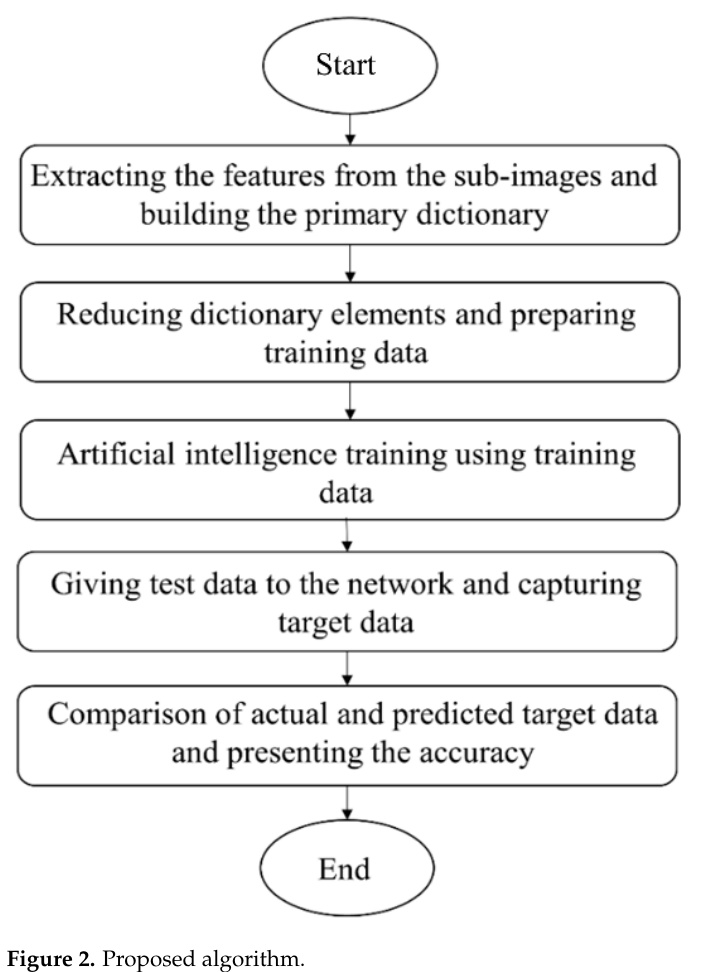
Figure 2. Proposed Figure 2. Proposed algorithm.